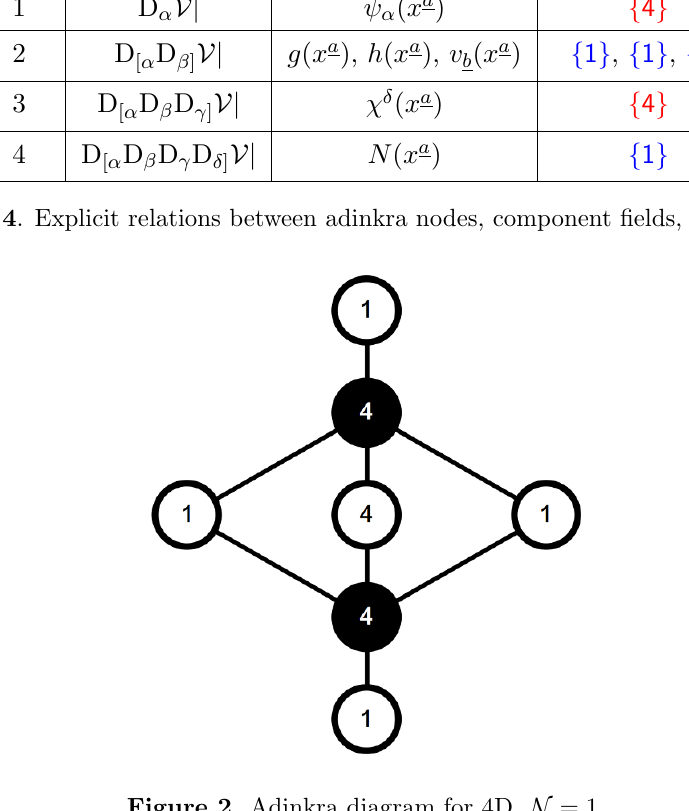
Figure 2 . Adinkra diagram for 4D, N =